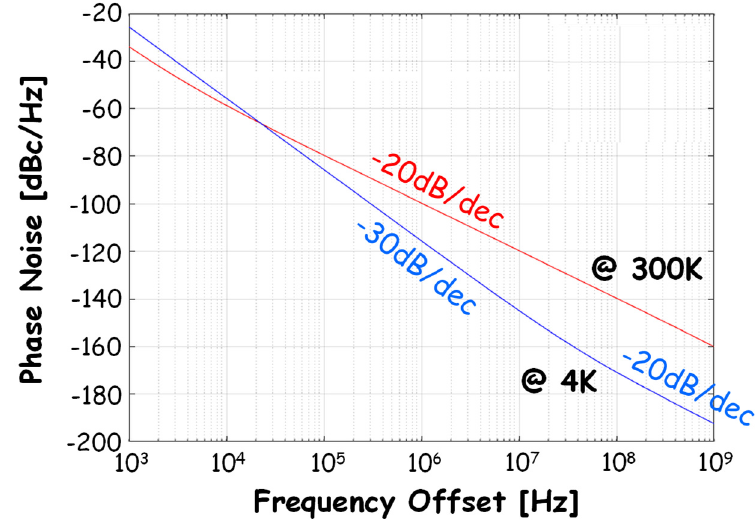
Figure 5. Phase noise at 300 K and 4 K.